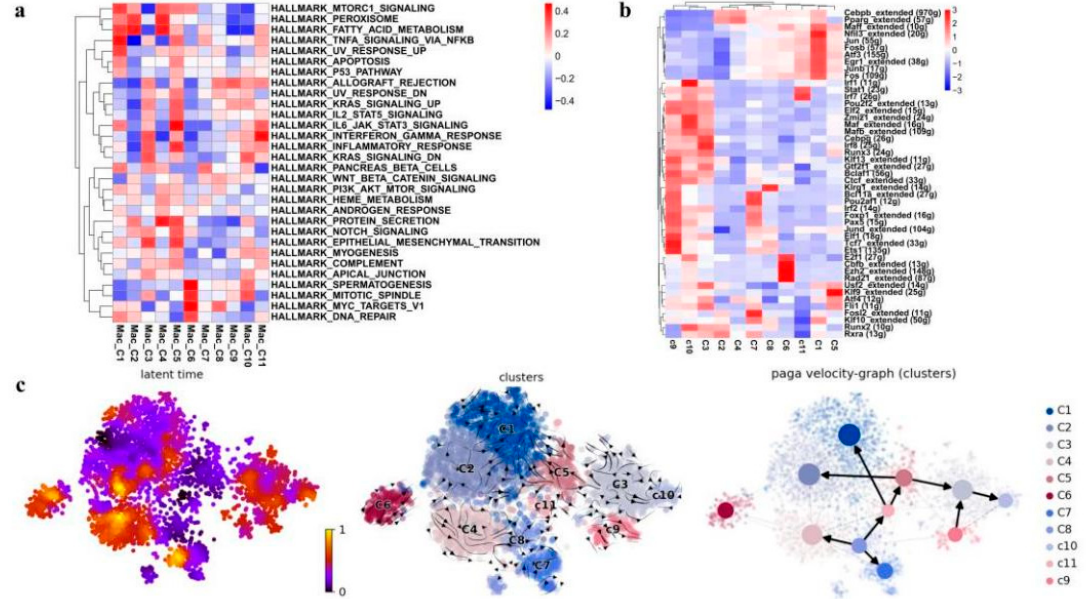
Figure 7. Identification and characterization of macrophage cell populations. ( a ) Heatmap showing the representative pathway terms of hallmark enriched in macrophage cellular subgroup. ( b ) The heat map exhibits the average regulon activities of transcription factors in macrophage cellular subgroup (top 10 regulons in each cluster were selected). The number in the parenthesis shows the downstream genes regulated by the corresponding transcription factors. ( c ) RNA velocity analysis of macrophage cellular subgroup with velocity field projected onto the PAGA plot of macrophages subclusters ( right panel). Arrows show the local average velocity evaluated on a regular grid and indicate the extrapolated future states of cells. Left panel: RNA velocity pseudotime analysis revealing the latent time of macrophages subclusters.